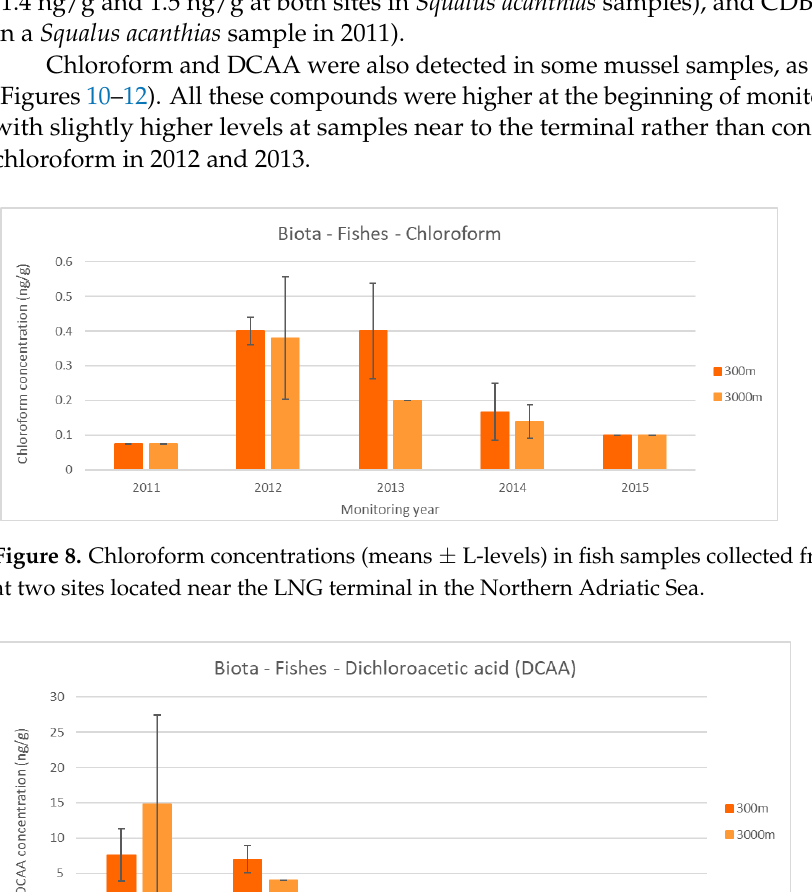
Figure 9. DCAA concentrations (means ± L-levels) in fish samples collected from 2010 to 2015 at two sites located near the LNG terminal in the Northern Adriatic Sea.